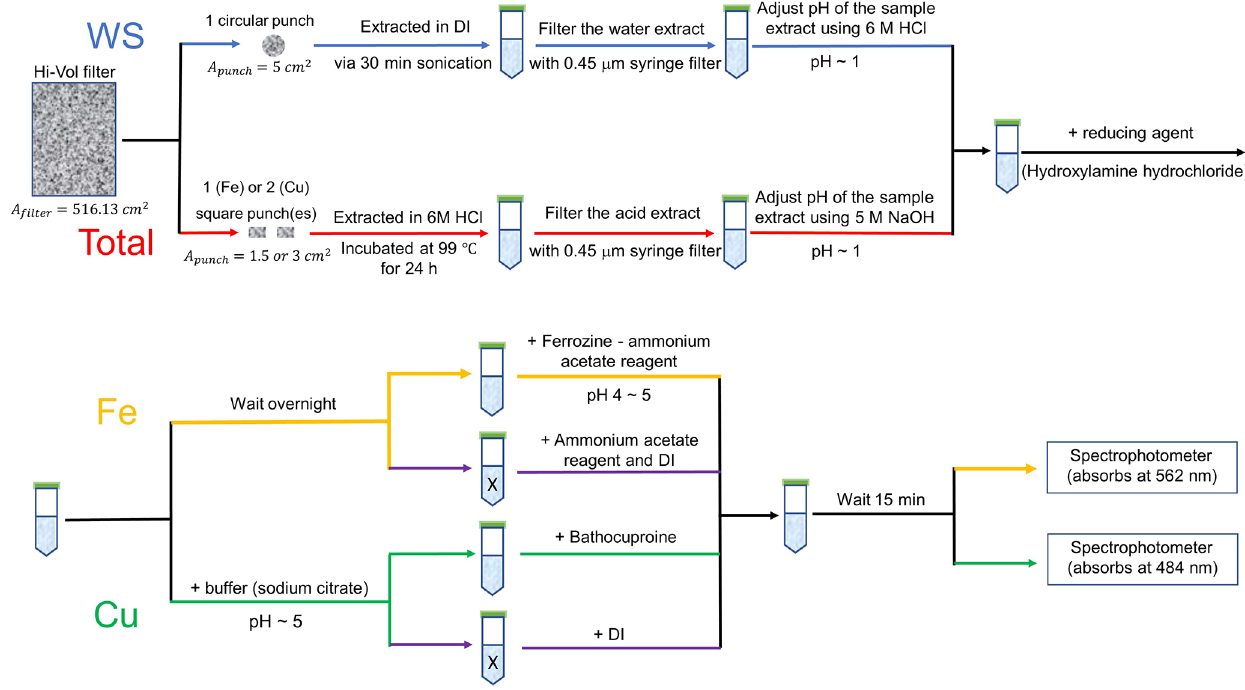
Figure 1. Schematic of the experimental procedures for the measurement of water-soluble (blue line) and total (red line) Fe and Cu. The upper schematic shows the processes common to both methods. The sample vial from this process is then analyzed for Fe or Cu via the process illustrated in the bottom schematic. In the bottom schematic the process for Fe (yellow line) or Cu (green line) is given. The black line is common to both the WS and total measurement (in the upper schematic) or common to both the Fe and Cu measurement (in the lower schematic). X refers to the liquid samples used to assess the interference of other light-absorbing species at 562 or 484nm (purple